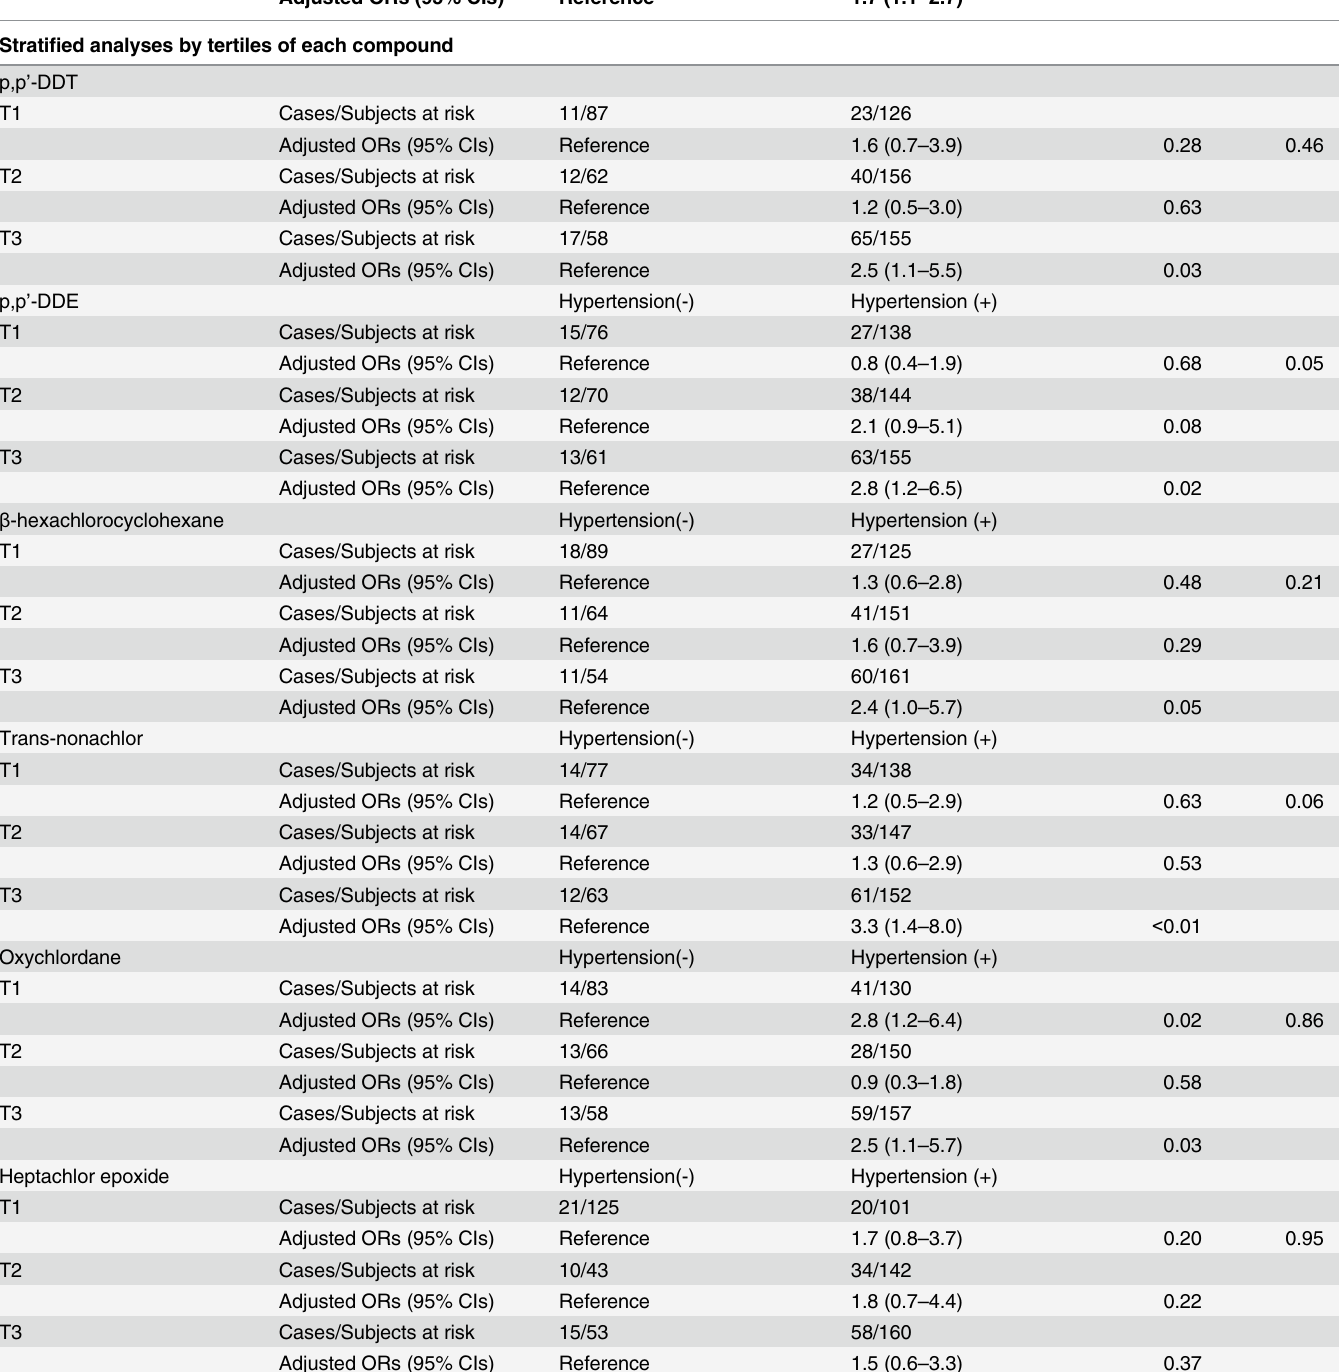
Table 3. Adjusted * odds ratios (ORs) and 95% confidence intervals (CIs) between hypertension and the risk of low Digit Symbol Substitution Test score ( < 25 th% of study subjects) among all subjects or stratified by serum concentrations of organochlorine (OC) pesticides. Hypertension (-) (n = 207) Hypertension (+) (n = 437) P value P interaction All subjects Cases/Subjects at risk 40/207